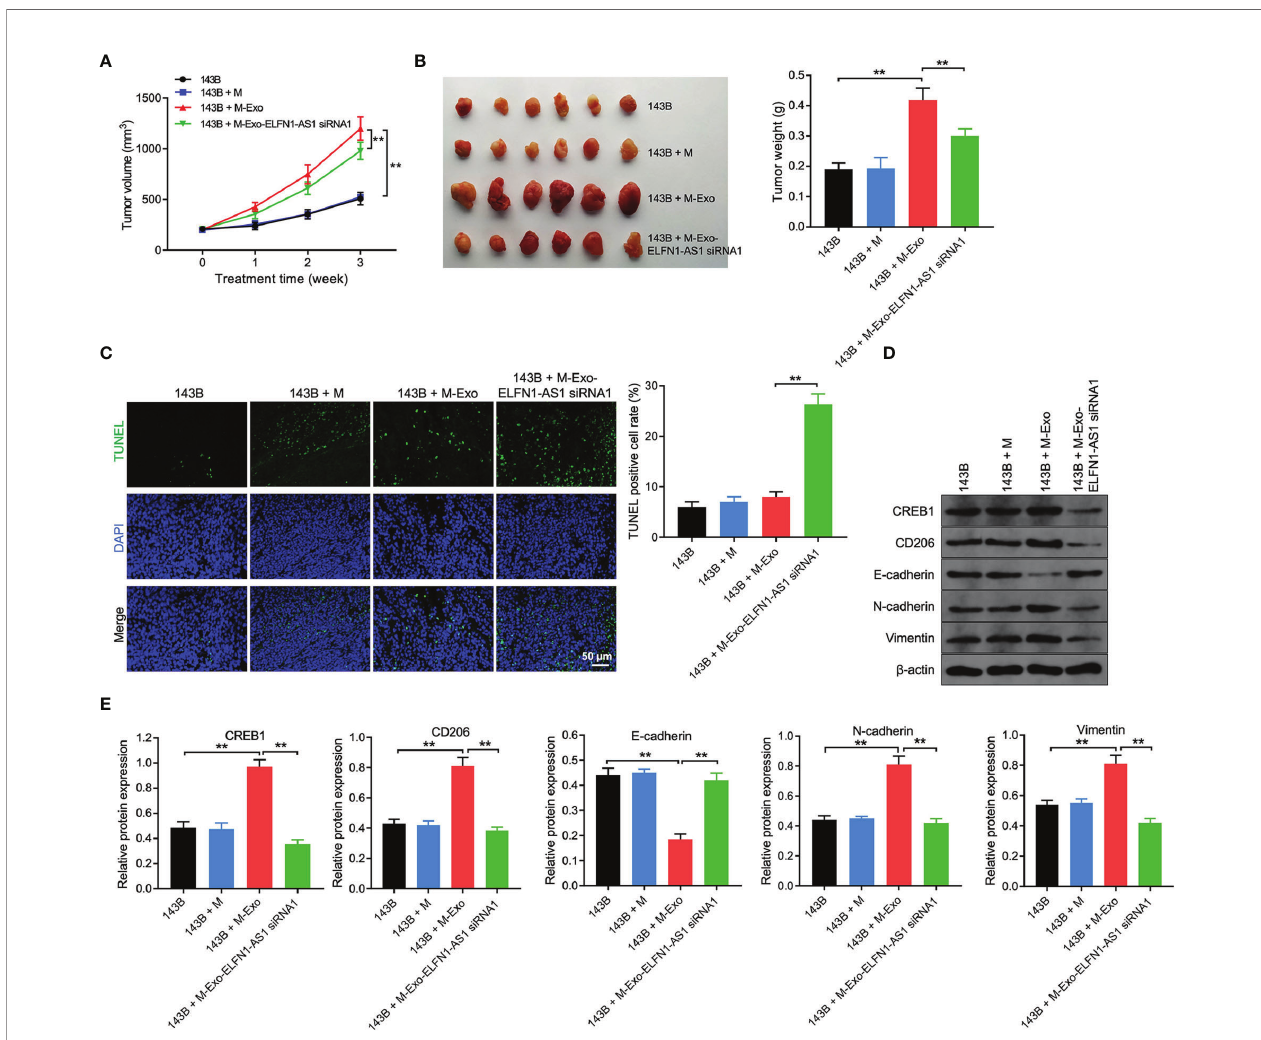
FIGURE 8 | Exosomes with ELFN1-AS1 promotes tumor growth via inducing macrophage M2 polarization in vivo. via in vivo (A) The volume of nude mice was monitored weekly (n = 6). (B) Xenograft tumors were collected, and tumor weights were calculated (n = 6). (C) Cell apoptosis in tumor tissues were detected using TUNEL assay (n = 3). (D, E) Western blot assay analysis of CREB1, CD206, E-cadherin, N-cadherin, and vimentin protein expression in tumor tissues (n = 3). The signi fi cance between four groups was analyzed by Student ’ s t test or one-way ANOVA respectively. **P <